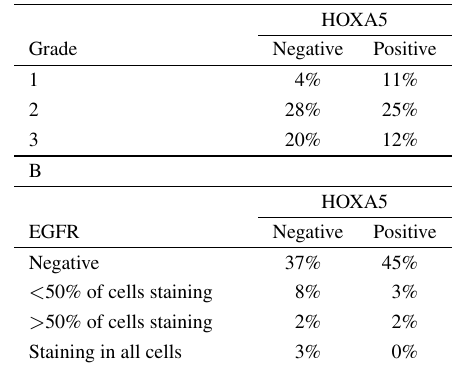
Expression of HOXA5 inversely correlates with tumor grade ( p < 0 . 05) and EGFR levels ( p < 0 .